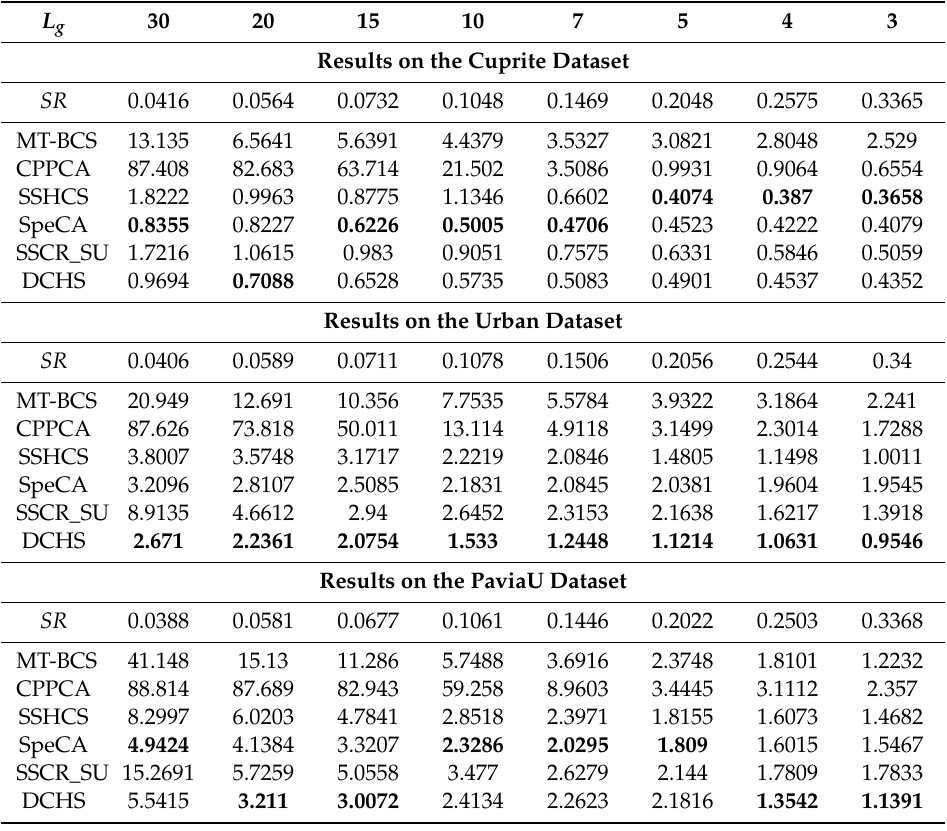
Table 1. Comparison of mean spectral angle mapper (MSAM) ( ◦ ) achieved by the various algorithms (the best results are in